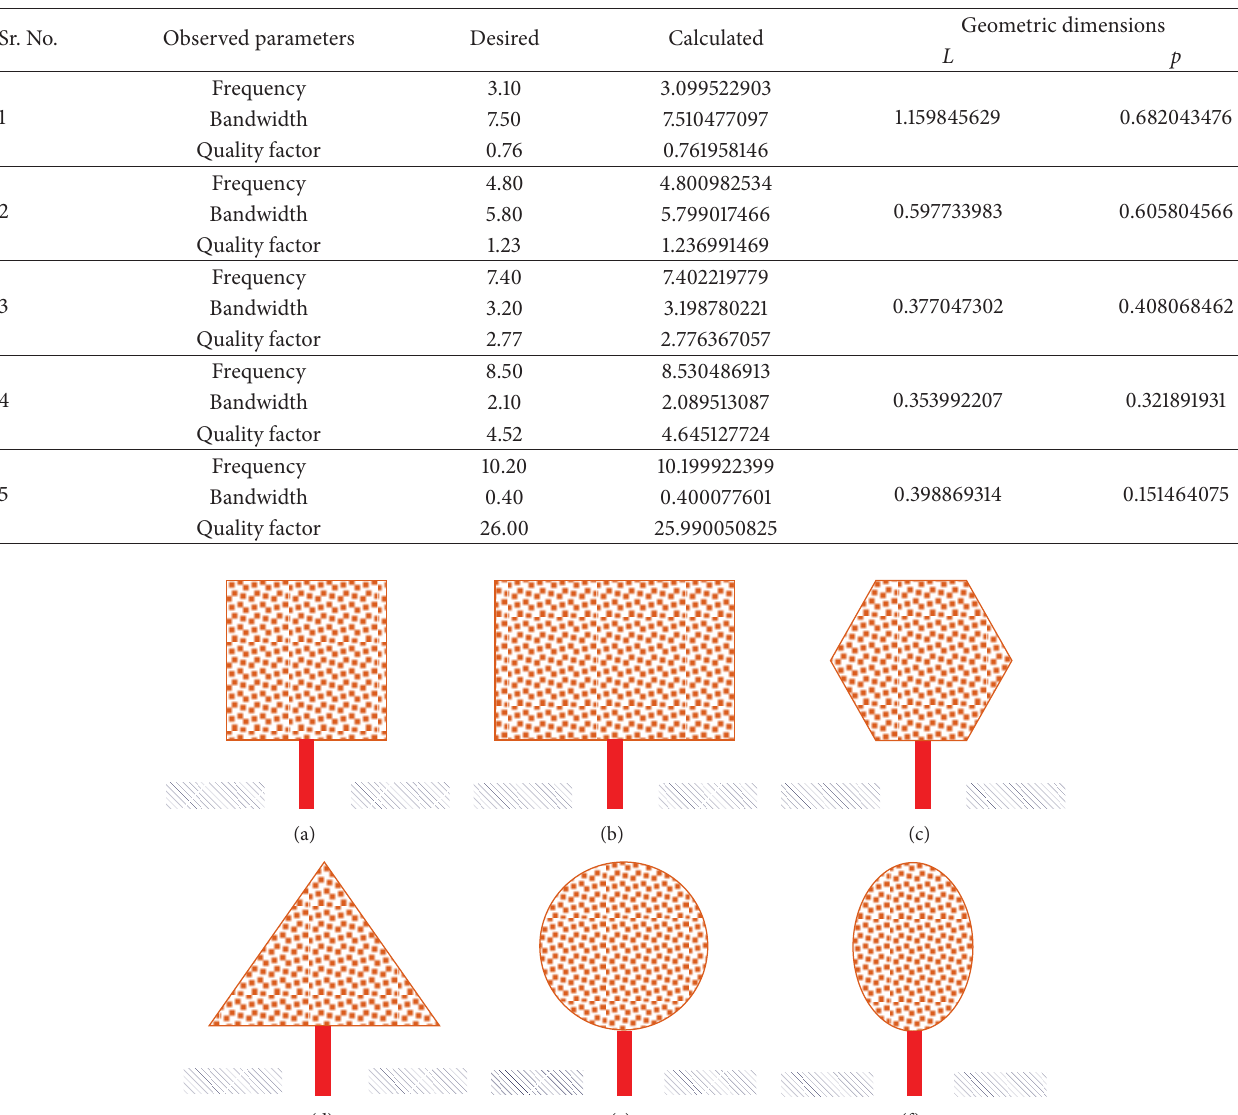
Table 1: Optimized values for PSMA at the lower frequency of 3.1, 4.8, 7.4, 8.5, and 10.2 GHz. Sr. No.